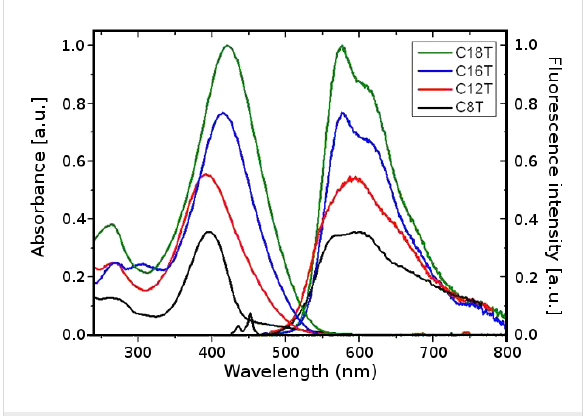
Figure 1: Absorption and fluorescence spectra of the macrocycles of Series I in dichloromethane (the excitation wavelength was chosen at the maximum of the absorption band).